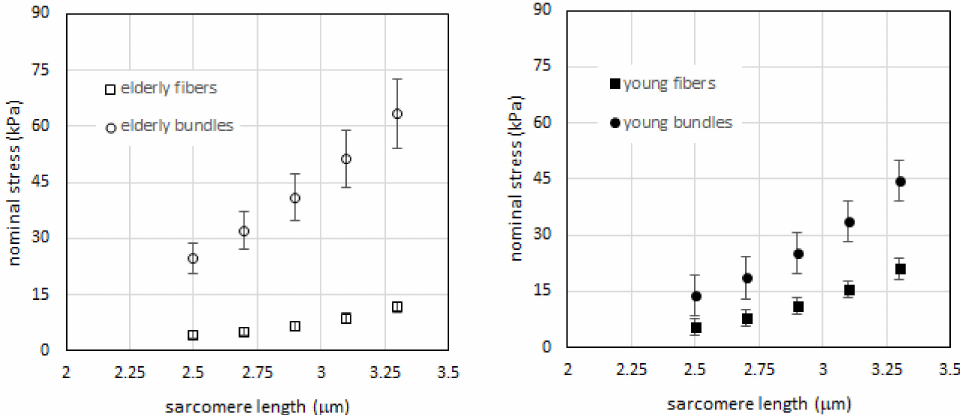
Figure 1. Left : passive tension vs. sarcomere length for fibers (open squares) and bundles (open circles) in elderly subjects. Fibers N = 11, cross-sectional area (CSA) 7718 ± 1499 µ m 2 , bundles N = 11 CSA 18,360 ± 2648 µ m 2 , (mean ± SEM), average 5 fibers in each bundle. Right : passive tension vs. sarcomere length for fibers (filled squares) and bundles (filled circles) in young subjects. Fibers N = 12, fiber CSA 7777 ± 886 µ m 2 , bundles N = 13 CSA 25,115 ± 2095 µ m 2 , (mean ± SEM), average 5 fibers in each bundle. Data are shown as mean value +/ - SEM (standard error of the mean), after interpolation with a cubic function as described in Experimental Procedures section.